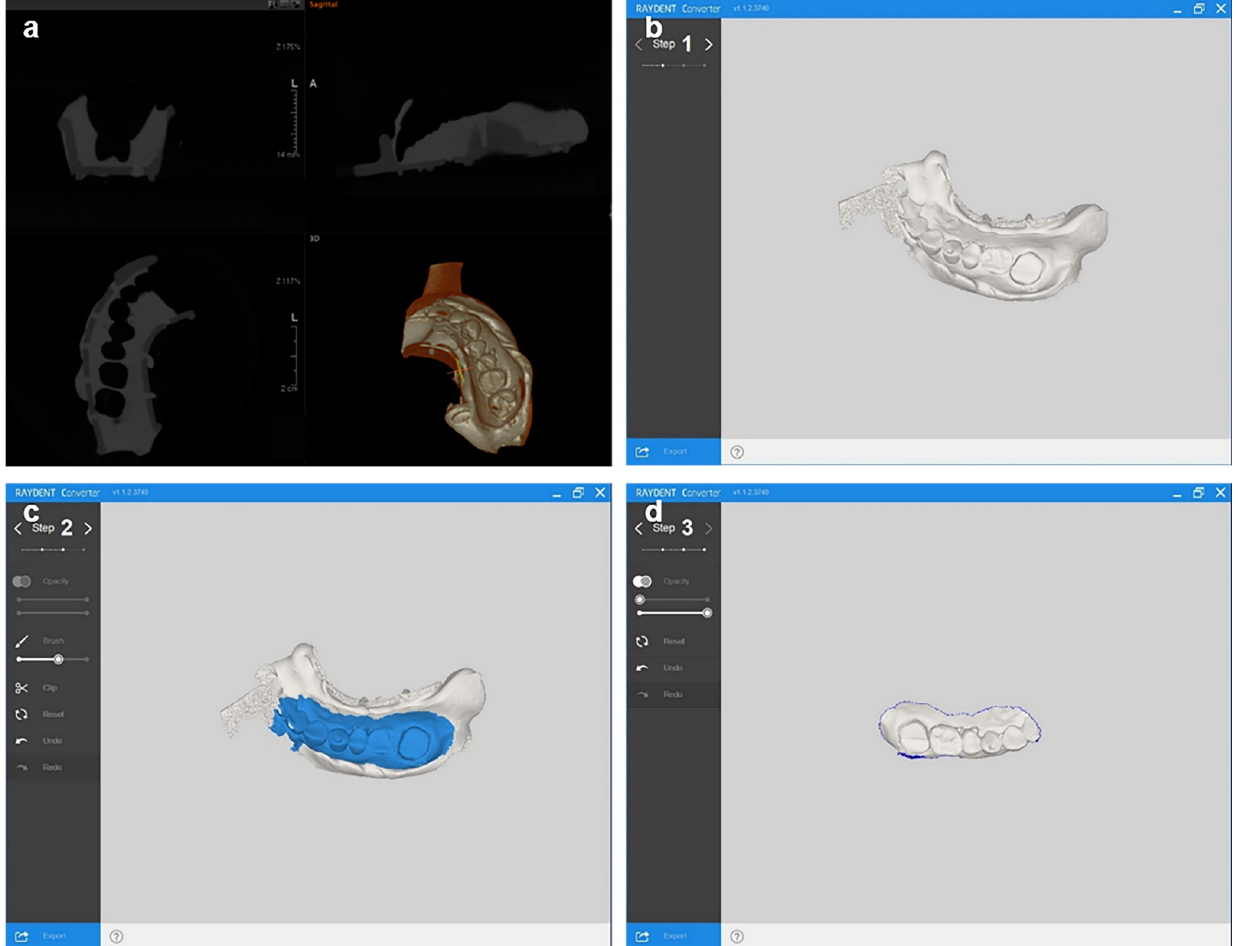
Fig 3. Conversion from the DICOM format to STL files using customized conversion software. (a) DICOM file loading, (b) negative data, (c) selection of the positive range, and (d) conversion to a positive format.